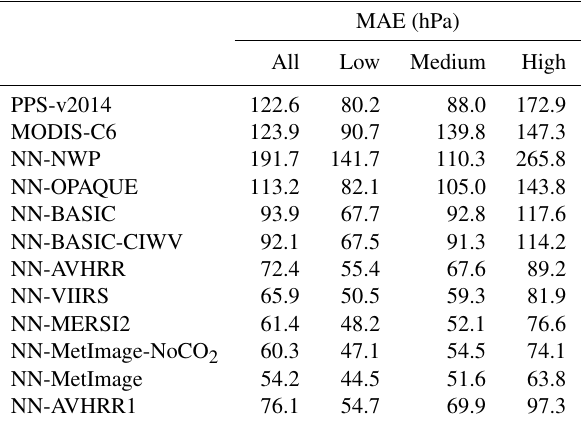
Table 5. Mean absolute error (MAE) for different algorithms com- pared to CALIOP top layer pressure. The final validation dataset (see Table 1), containing 1832432 pixels (45% high, 39% low and 16% medium level clouds) is used. Pixels with valid pressure for PPS-v2014, MODIS-C6, and CALIOP are considered. The low, medium and high classes are from CALIOP feature classification flag. MAE (hPa) All